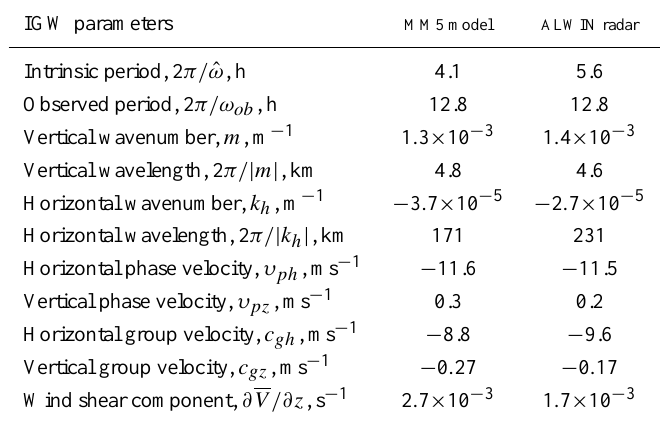
Table 2. Gravity waves parameters derived from the results of the Stokes-parameter analysis as shown in Table 1 for the MM5 model output and radar measurements at